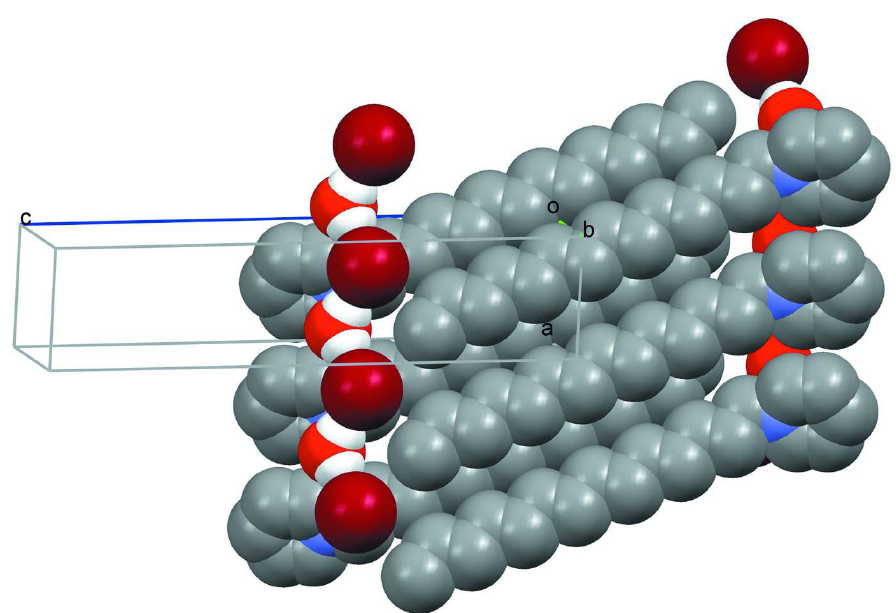
Figure 2 Packing of (I) viewed in the b direction. Hydrogen atoms not involved in hydrogen bonding have been removed for